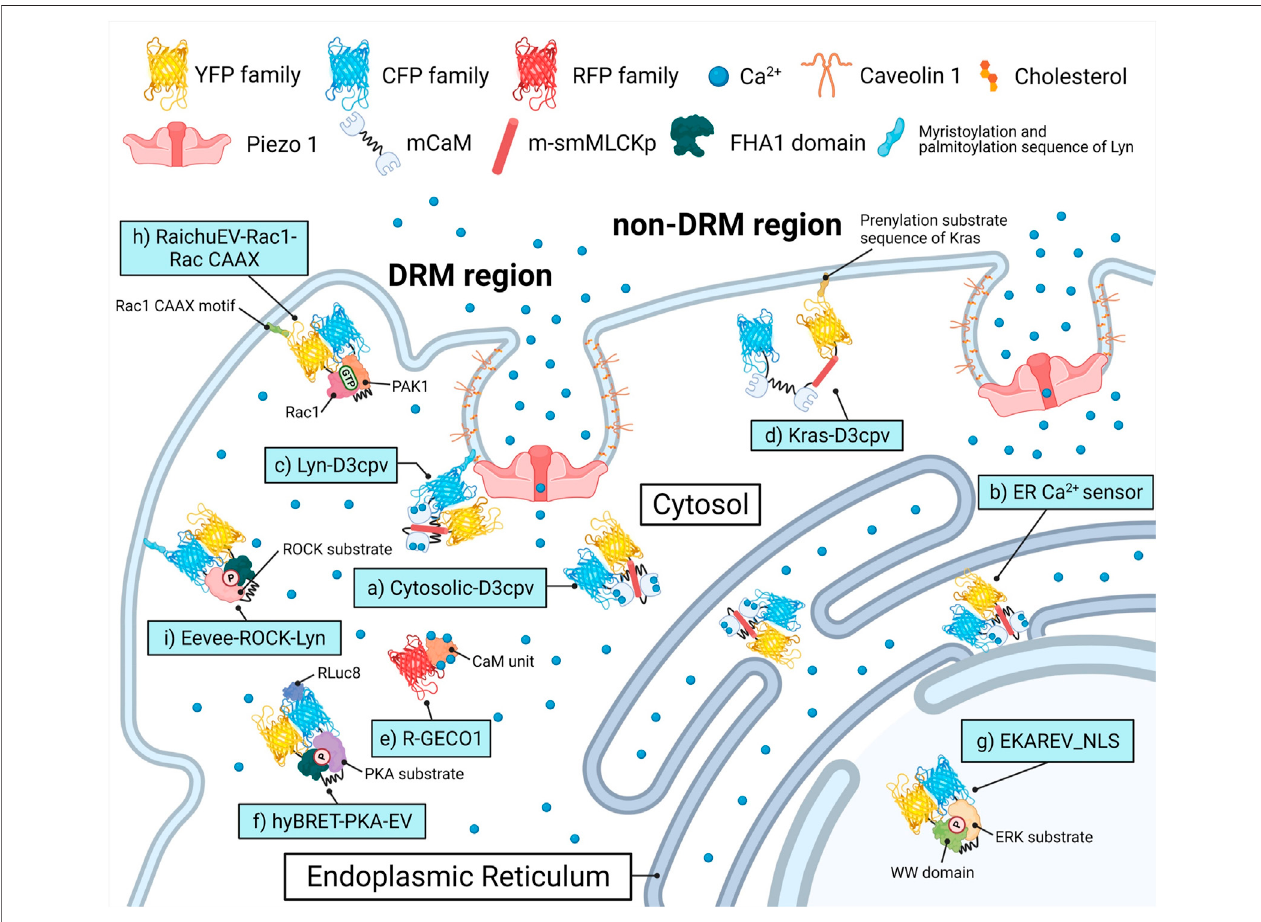
FIGURE 1 | Biosensors and targeting strategies employed in this study. Each of the biosensors visualized the target ’ s activity in a speci fi c microenvironment and was expressed solely to avoid crosstalk between optical signals of fl uorescence proteins. (A) Cytosol Ca 2+ indicator, Cytosolic-D3cpv used in Figures 2 , 5 . (B) Endoplasmic reticulum (ER) Ca 2+ indicator, ER Ca 2+ sensor used in Figure 3 . (C) DRM region Ca 2+ indicator, Lyn-D3cpv used in Figure 4 . (D) non-DRM region Ca 2+ indicator,Kras-D3cpvusedin Figure4 . (E) CytosolicCa 2+ indicator,R-GECO1usedin Figure4 . (F) PKAactivityindicator,hyBRET-PKA-EVusedin Figure6 . (G) ERK activity indicator, EKAREV_NLS used in Figure 6 . (H) Rac1 activity indicator, RaichuEV-Rac1-Rac CAAX used in Figure 7 . (I) ROCK activity indicator, Eevee- ROCK-Lyn used in Figure 7 . DRM, detergent-resistant membrane. YFP, yellow fl uorescent protein. CFP, cyan fl uorescent protein. RFP, red fl uorescent protein.